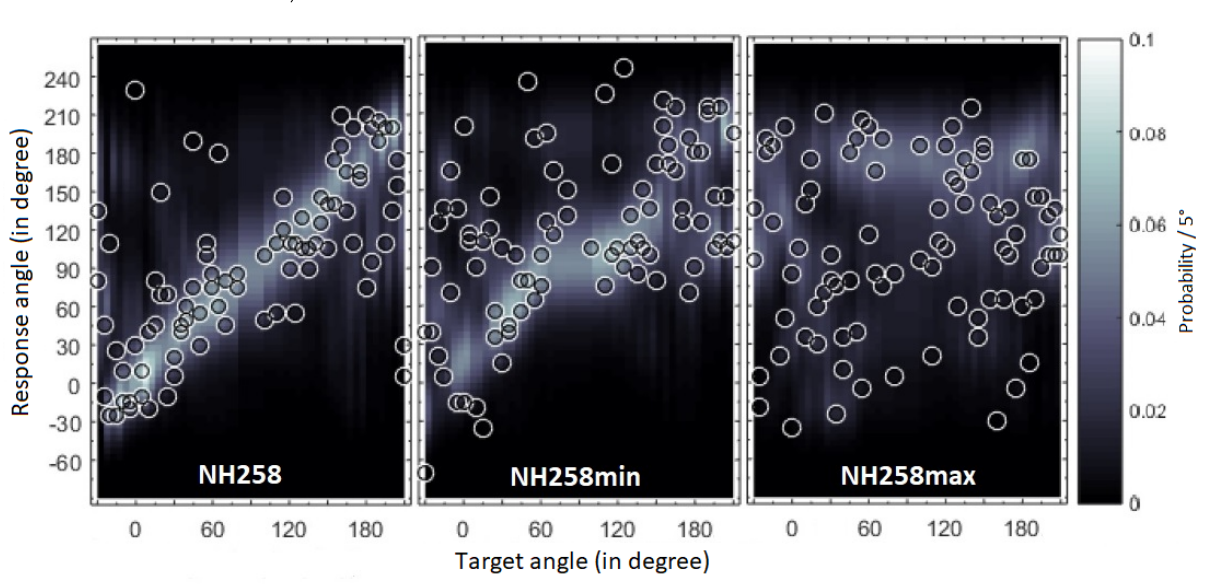
Figure 1. Localization model for prediction of localization errors in the sagittal plane. Probabilistic response predictions are encoded by brightness according to the color bar to the right. Predicted response angles are shown as open circles. NH258: normal hearing listener number 258; min: minimal deviant head-related transfer function; max: maximal deviant head-related transfer